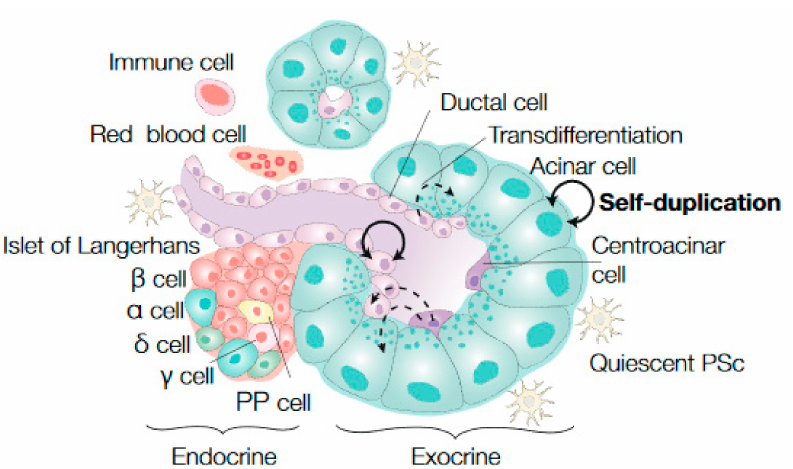
Figure 1. Stem cell dynamics in the exocrine pancreas during homeostasis. The pancreas consists of an endocrine and an exocrine compartment. The endocrine cells are clustered in islets (the islets of Langerhans) and include α cells, β cells, δ cells, pancreatic polypeptide (PP), and γ cells. The exocrine compartment contains enzyme-producing acinar cells, a ductal system that is lined up with ductal cells and centroacinar cells, which are located at the tips of ducts, between the acinar and ductal cells. Important microenvironmental factors of the homeostatic pancreas are immune, red blood, and quiescent pancreatic stellate cells (PSc). The current literature on stem or progenitor cells in the exocrine homeostatic pancreas predominantly points to a model in which homeostasis is maintained by self-renewal of mature pancreatic cell types (self-duplication, solid black arrows). However, few (lineage tracing) studies identified multipotent progenitor cells (ductal and centroacinar cells) that were able to transdifferentiate to other exocrine pancreatic cells (acinar and ductal cells), albeit rare events (indicated by dashed